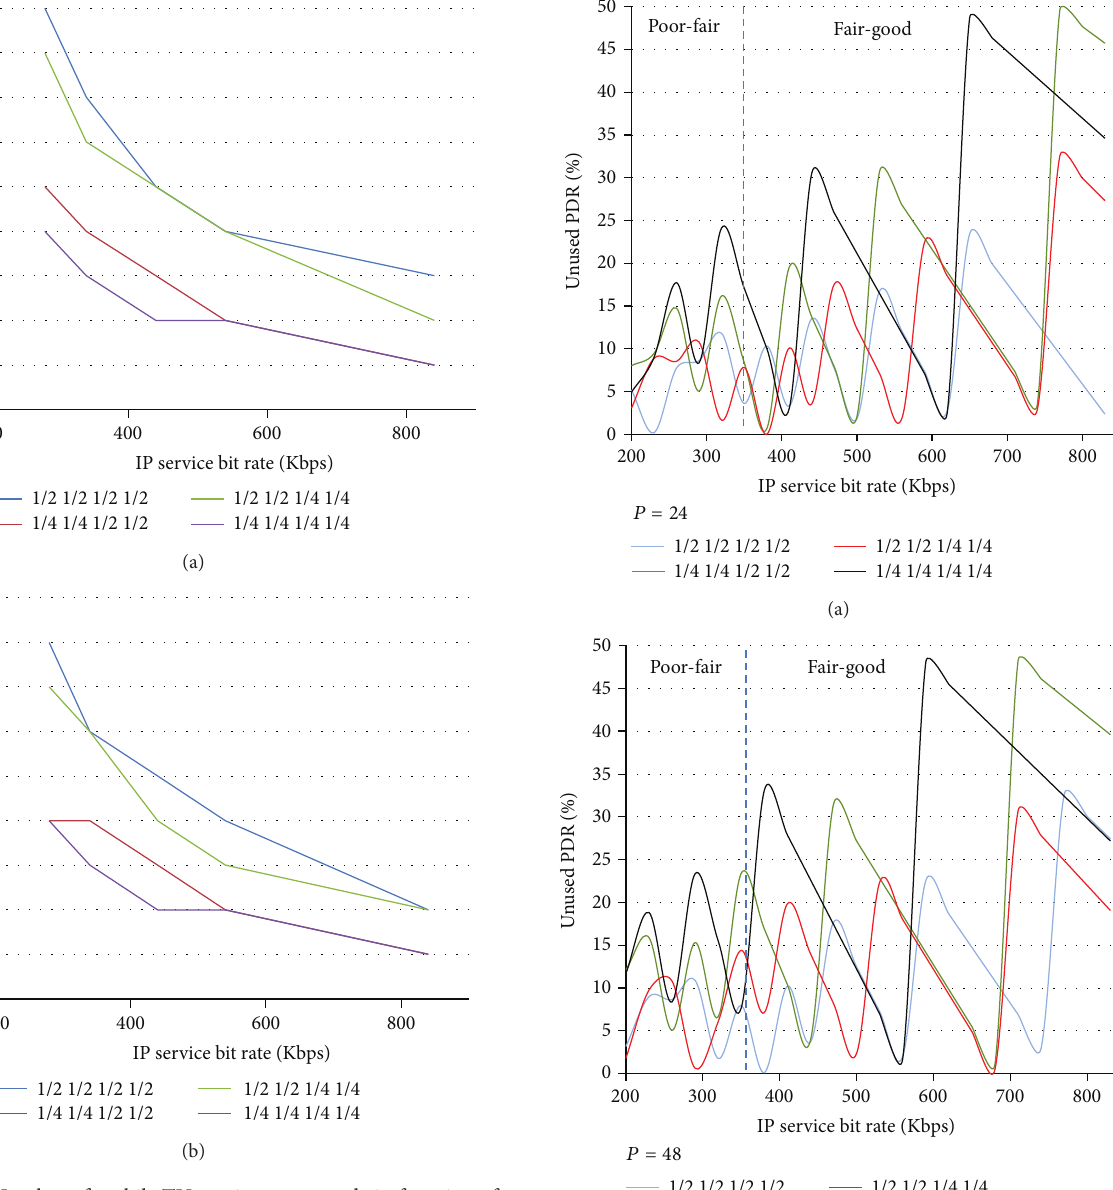
Figure 4: Number of mobile TV services per parade in function of minimum service bit rates guaranteeing certain video qualities for different code rates and RS codes: (a) 𝑃 = 24 , (b) 𝑃 = 48 .